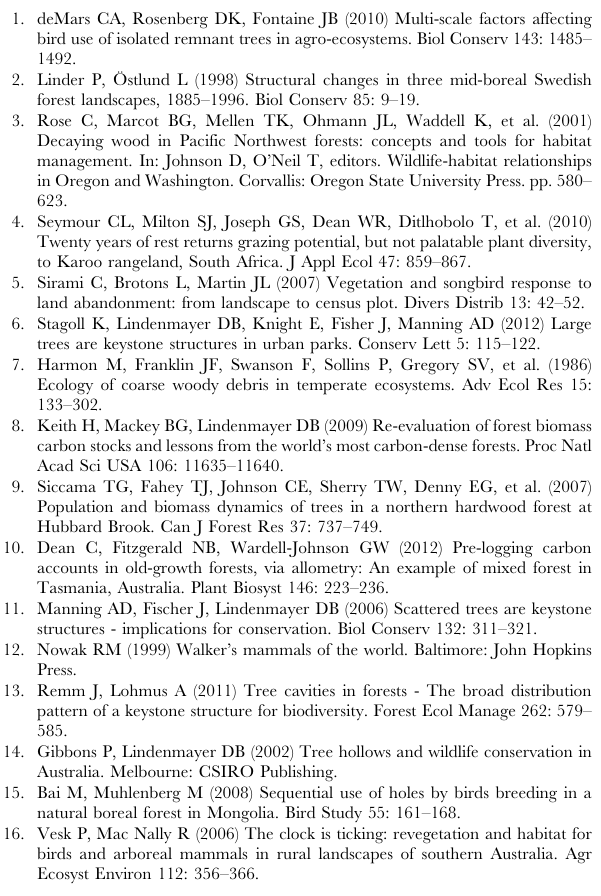
Table S1 Transition probability matrices for fire severity classes computed for 1997–2011 and